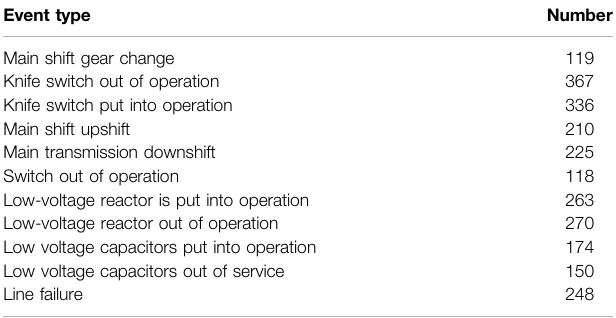
TABLE 2 | Distribution of event types.